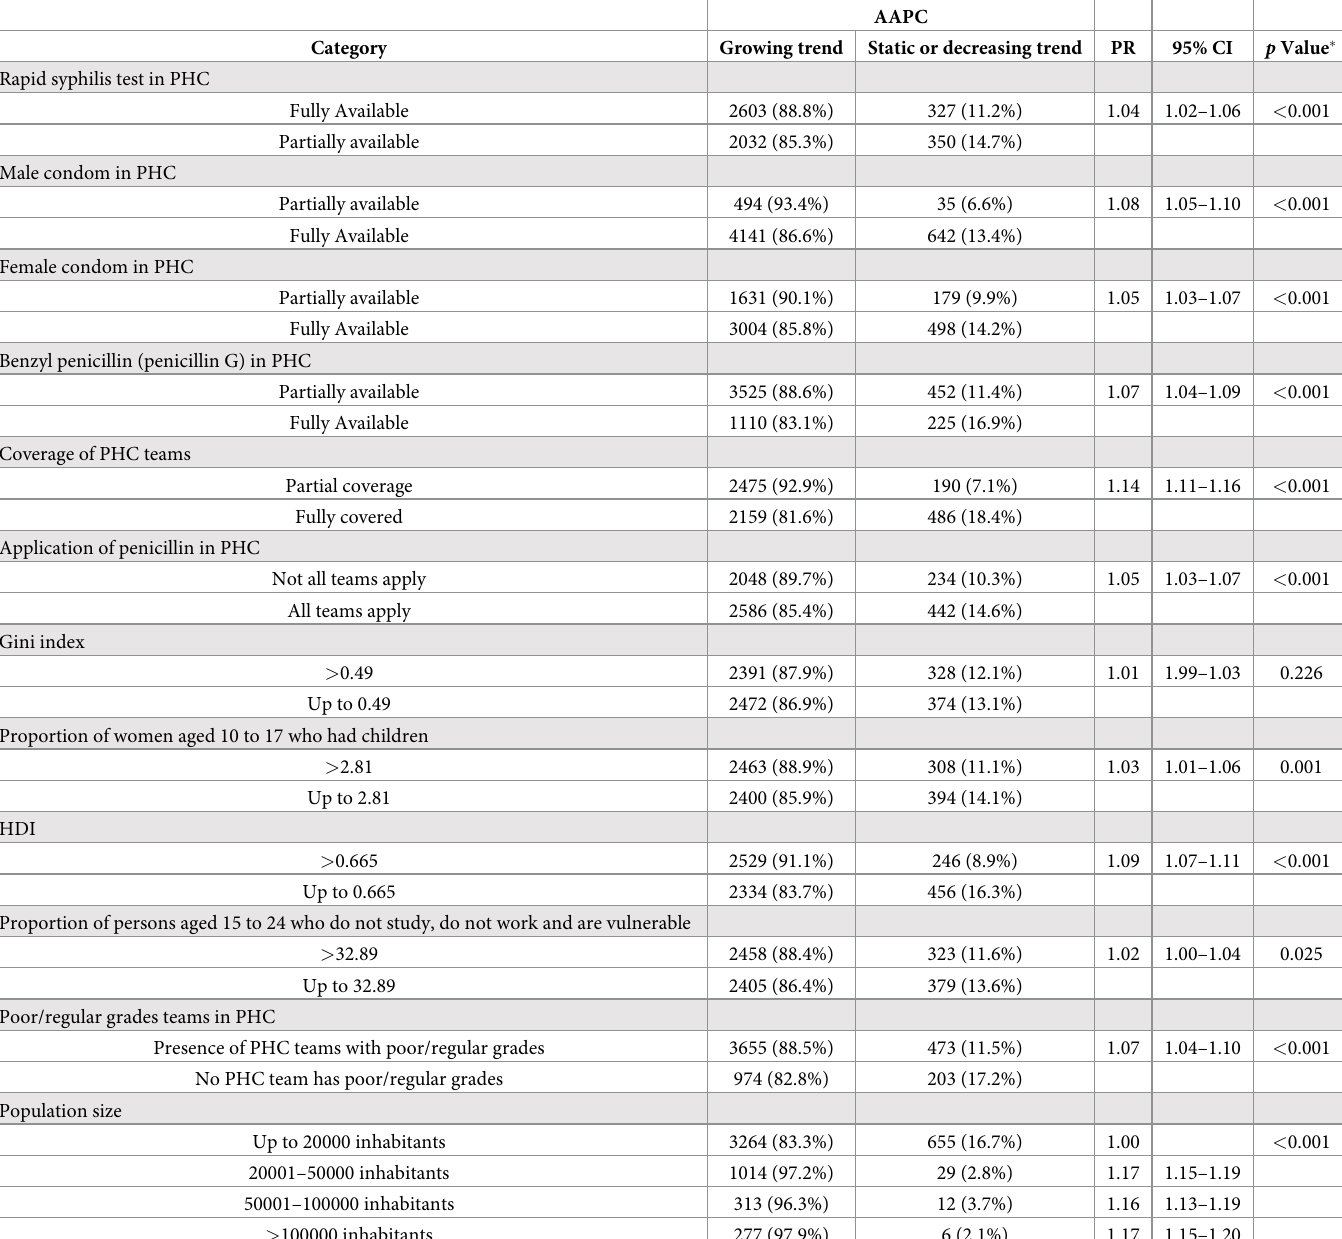
Table 3. Comparison of the proportions of the AAPC trends with the variables related to the basic health service and socioeconomic